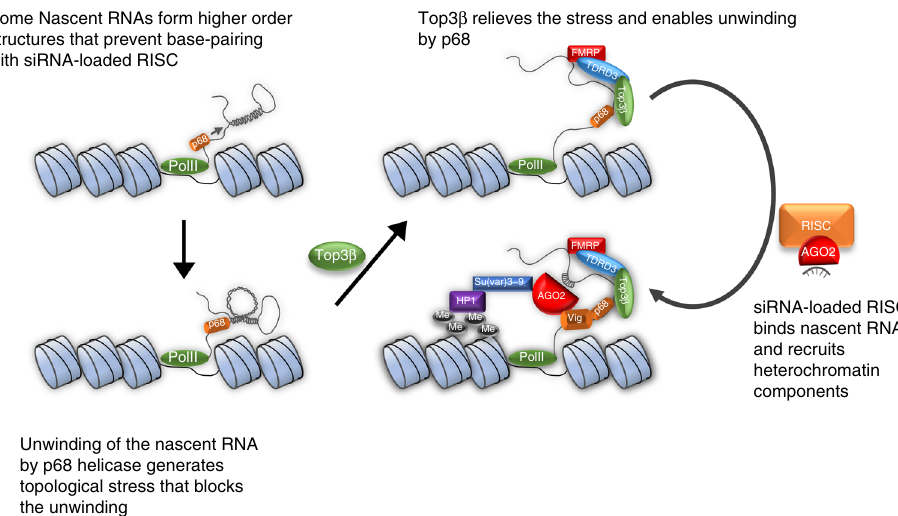
Fig. 9 Top3 β promotes heterochromatin formation by interacting with RNAi machinery. A model illustrating how Top3 β works with RISC in heterochromatin formation and transcriptional silencing. The nascent RNA transcribed from heterochromatin may form secondary and other structures by base-pairing with itself, which prevents access by siRNA-loaded RISC. These RNA structures are unwound by p68 helicase of RISC, and this process may produce torsional stress. Top3 β may relieve this stress by facilitating the unwinding process and makes nascent RNA accessible to base pairing by siRNA- loaded RISC. Binding of RISC to the nascent RNA may recruit HP1 and H3K9 methyltransferases to assemble heterochromatin. The coordinated actions of p68-Top3 β in resolving complex RNA structures may resemble those of their homologs, BLM-Top3 α , in resolving complex DNA are excluded from further analyses. The input-subtracted scores for each mutant were compared with those of the control ( w 1118 ) by using the bedtools suite intersect , with settings of 50% cross and 200 cut-off. Three categories of ChIP islands were obtained: the mutant-loss islands, mutant-obtained islands, and the mutant/wildtype-shared islands; in which the ChIP signals are decreased, increased, and of no change, respectively. These islands were combined to produce the bedgraph format fi les, which were loaded onto genome browser for manual analysis of ChIP signals for their chromosome location, base coverage area, relative levels, and distributions. Comparison of data of 3 samples or more used bedtools multiIntersectBed with the same cross criteria and cutoff score. For quanti fi cation, SICER signals from pericentric heterochromatin and euchromatin of chromosome 2 and 3 were separately calculated for the percentage of islands that are decreased, increased, or of no change in each mutant comparing to the control. The total length covered by each type of islands was also calculated for pericentric heterochromatin. The pericentric heterochromatin regions are distinguished from euchromatin based on chromosome band, which is largely consistent with our ChIP-seq data of HP1. They were manually set as: 2L: 22,090,000 – 23,513,711; 2R: 1 – 4,505,672; 3L: 23,247,000 – 28,110,226; 3R: 1 – 4,165,641. The remaining regions on the two chromosomes were treated as euchromatin in calculations. The quanti fi cation of HP1 data is based on average of SICER scores from 3 independent ChIP experiments for Top3 β , 2 for AGO2 , and 2 for Top3 β /AGO2 mutants. The quanti fi cation of H3K9me2 and H3K9me3 data is based on SICER analysis from 3 independent ChIP experiments. The overlapping of ChIP islands between HP1, Top3 β , and AGO2 was calculated based on the width of ChIP SICER peaks. To summarize, both heterochromatin and euchromatin SICER-predicted islands were selected depending on the subject. The overlaps between two ChIP SICER scores were obtained by crossing the two ChIP SICER islands using bedtools intersect with at least 50% overlap of the shortest island. The uncrossed portions were obtained by subtracting the crossed SICER island ’ s width from the total islands of either heterochromatin or euchromatin. The percentage of the SICER islands of a special protein in total heterochromatin was calculated by using the width of SICER islands divided by the length of total heterochromatin of chromosome 2 and 3 (14,956,269 bases). RNA-sequencing and microarray analysis . A total of 200 μ l Drosophila heads/per sample were collected by fast freezing and sieving. Total RNA was extracted using TRIzol reagent according to the manufacturer ’ s protocol (Thermo Fisher, Wal- tham, MA, USA). Three sets of independently prepared RNA samples were applied for RNA sequencing and microarray assay. For the microarray, RNA concentration and quality were measured by Nanodrop (Thermo Fisher, Waltham, MA, USA) and the Agilent Bioanalyzer RNA 6000 Chip (Agilent, Santa Clara, CA). Two hundred nanograms of total RNA was labeled using the Agilent Low-Input QuickAmp Labeling Kit, and was puri fi ed and quanti fi ed according to the man- ufacturer ’ s recommendations. A total of 600 ng Cy3-labeled cRNA was hybridized